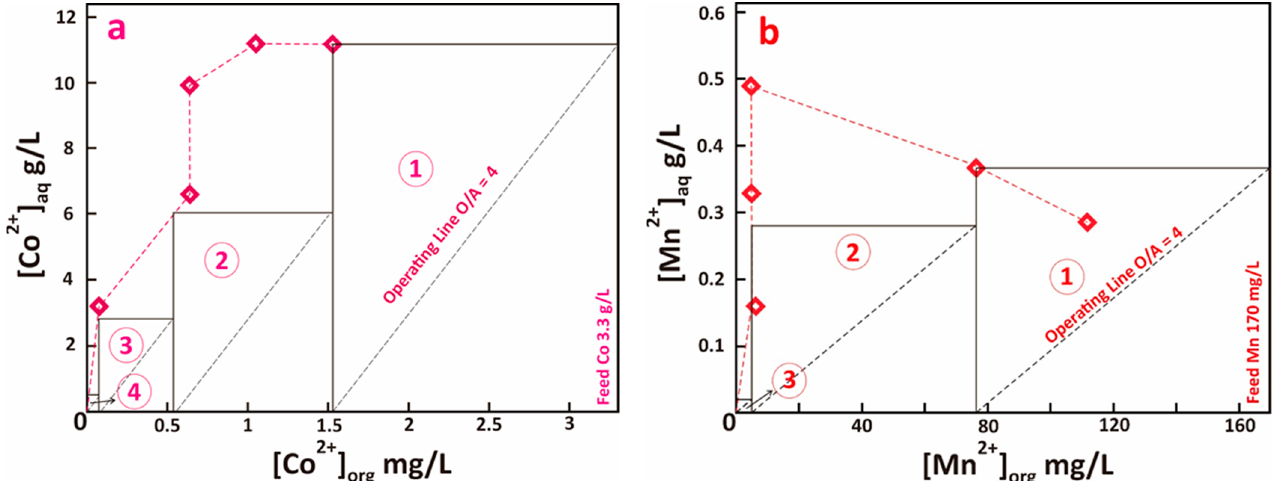
Figure 7. Stripping isotherm of ( a ). Co and ( b ). Mn from loaded organic (feed Co 3.3 g/L, Mn 0.17 g/L) using sulfuric acid 0.2 M, McCabe-Thiele plot is shown for O/A ratio 5 (Co) and 4 (Mn).